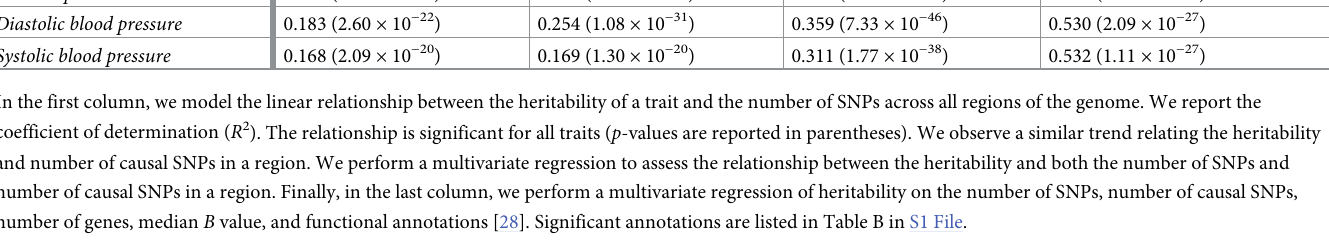
Table 2. Linear relationship between heritability, number of SNPs, number of causal SNPs, and genomic annotations. Trait